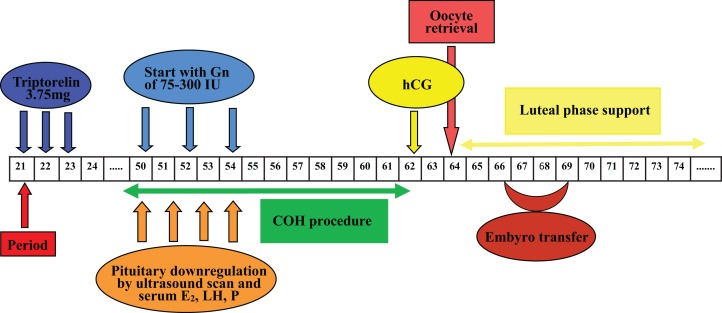
Flow chart of GnRH agonist prolonged regimen in Group 2.One depot of 3.75 mg Triptorelin was injected from mid-luteal phase of last menstrual cycle, the rest procedures were similar to those of Group 1. COH, controlled ovarian hyperstimulation; E2, estradiol; Gns, gonadotropins; hCG, human chorionic gonadotrophin; LH, luteinizing hormone; P, progesterone.